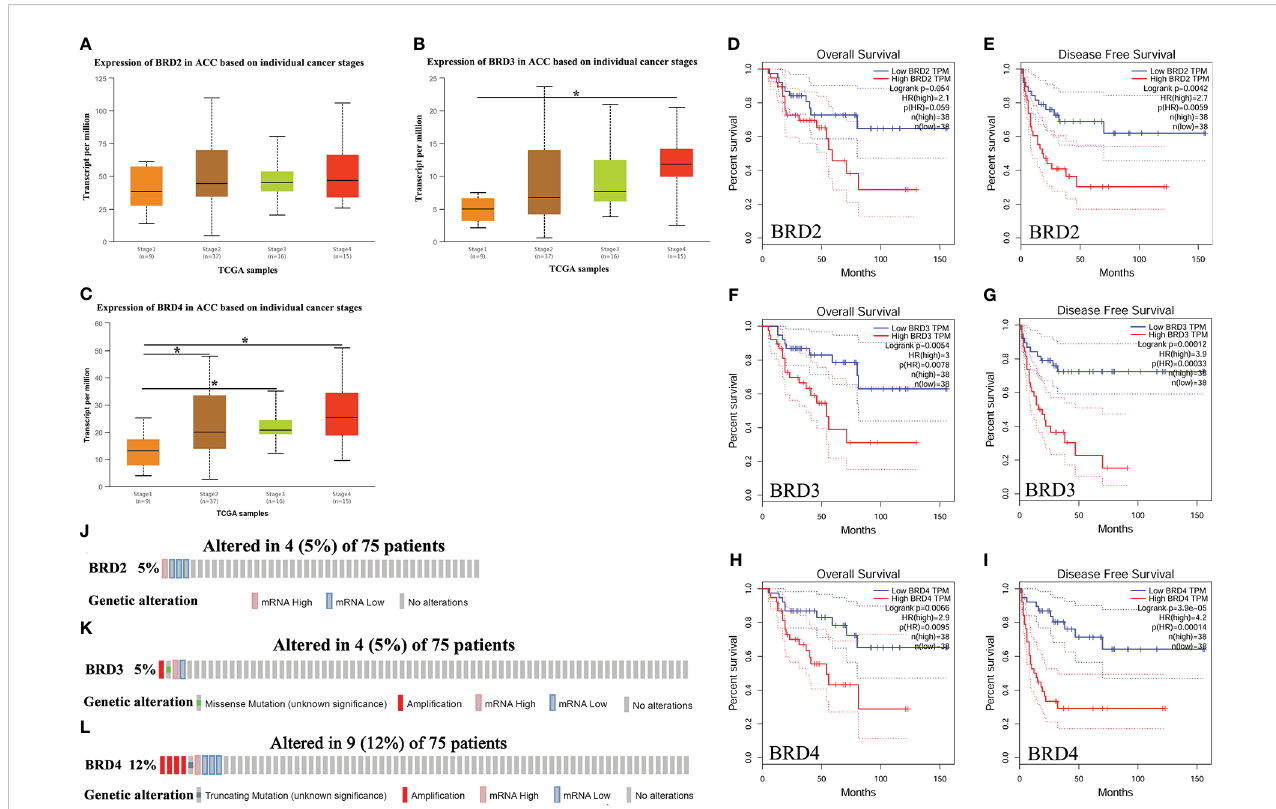
FIGURE 1 The expression, prognostic value, and genetic alteration of BET family in ACC patients (UALCAN, GEPIA, and cBioPortal). (A) The expression of BRD2 in ACC patients based on individual cancer stages (UALCAN); (B) The expression of BRD3 in ACC patients based on individual cancer stages (UALCAN); (C) The expression of BRD4 in ACC patients based on individual cancer stages (UALCAN); (D) The overall survival curve of BRD2 in patients with ACC (GEPIA); (E) The disease-free survival cure of BRD2 in patients with ACC (GEPIA); (F) The overall survival curve of BRD3 in patients with ACC (GEPIA); (G) The disease-free survival cure of BRD3 in patients with ACC (GEPIA); (H) The overall survival curve of BRD4 in patients with ACC (GEPIA); (I) The disease-free survival cure of BRD4 in patients with ACC (GEPIA). (J) Genetic alteration of BRD2 in ACC (cBioPortal); (K) Genetic alteration of BRD3 in ACC (cBioPortal); (L) Genetic alteration of BRD4 in ACC (cBioPortal). Data are expresssed as mean ± SE. * P <